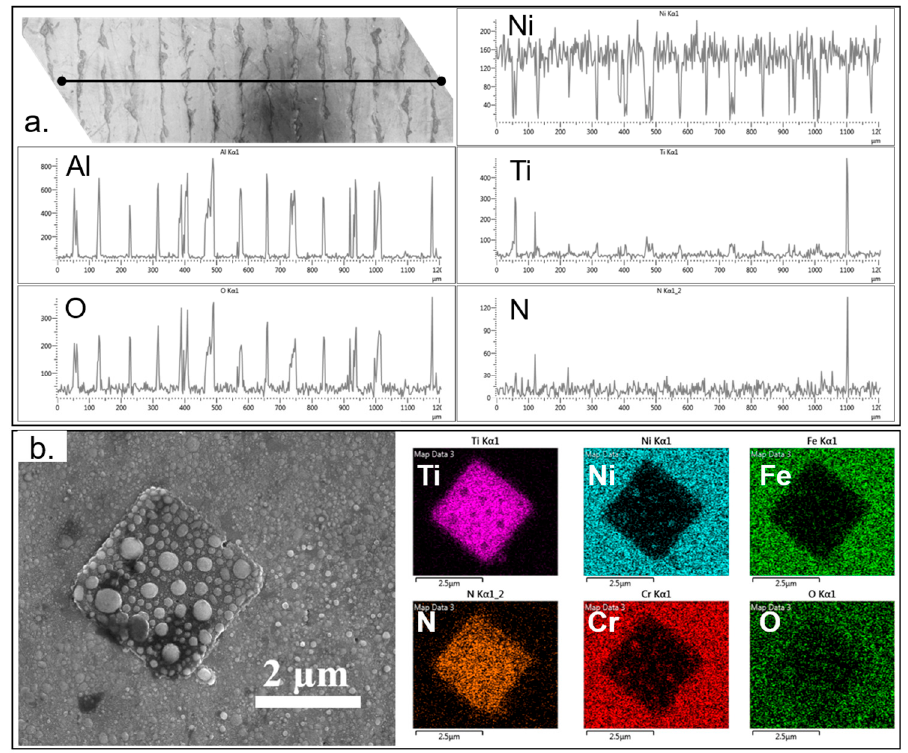
Figure 7. ( a ) EDS line scan over the top surface of a cube produced under argon and 50 ppm residual O 2 . ( b ) EDS map over a titanium nitride observed on the top surface.